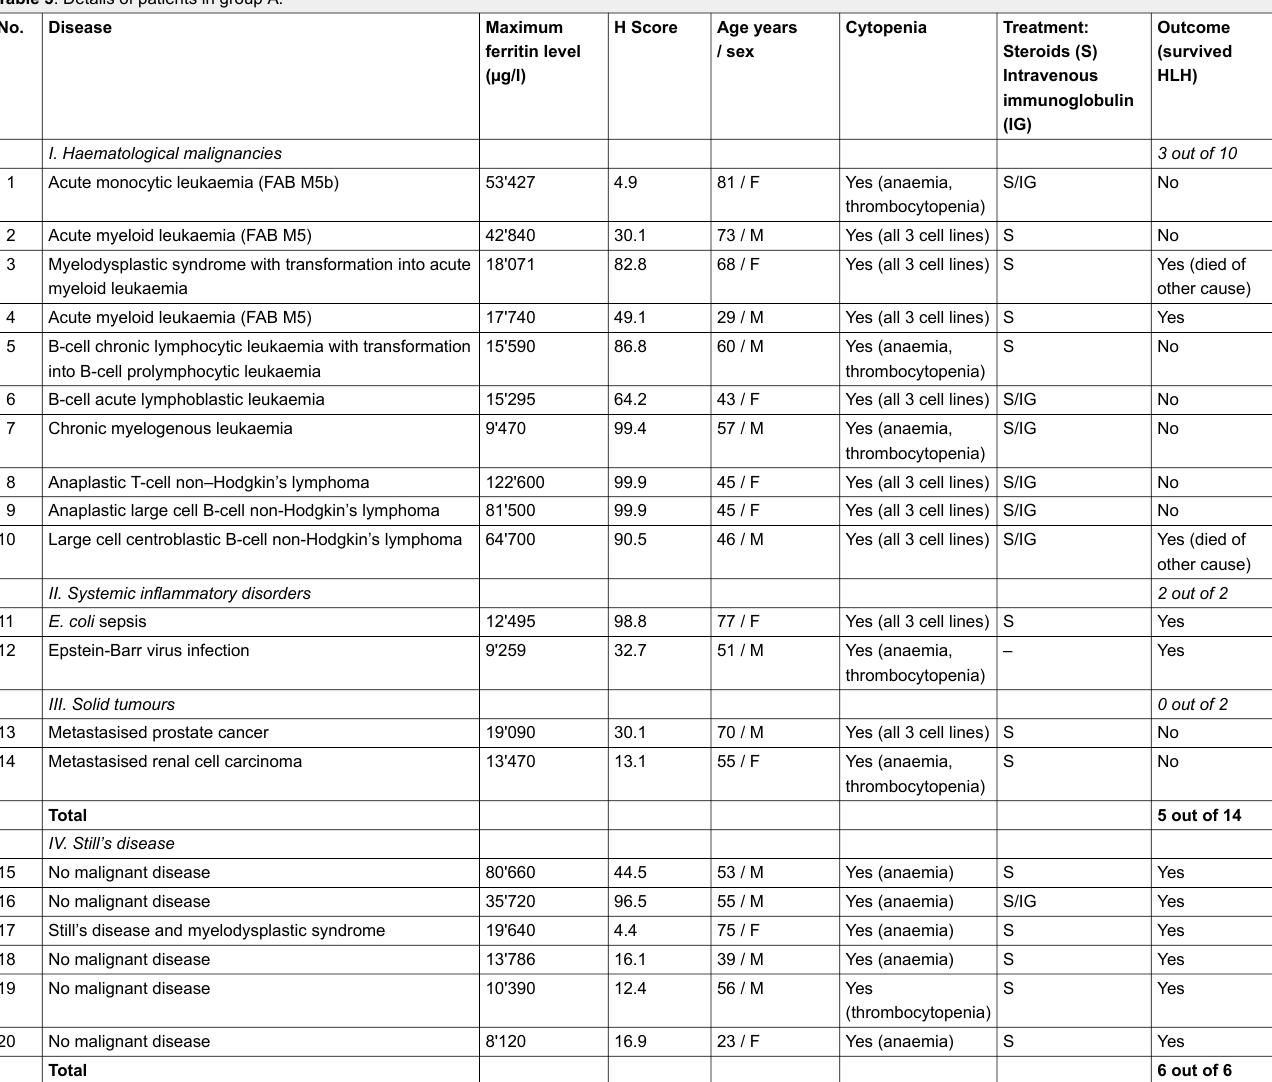
Table 3 : Details of patients in group